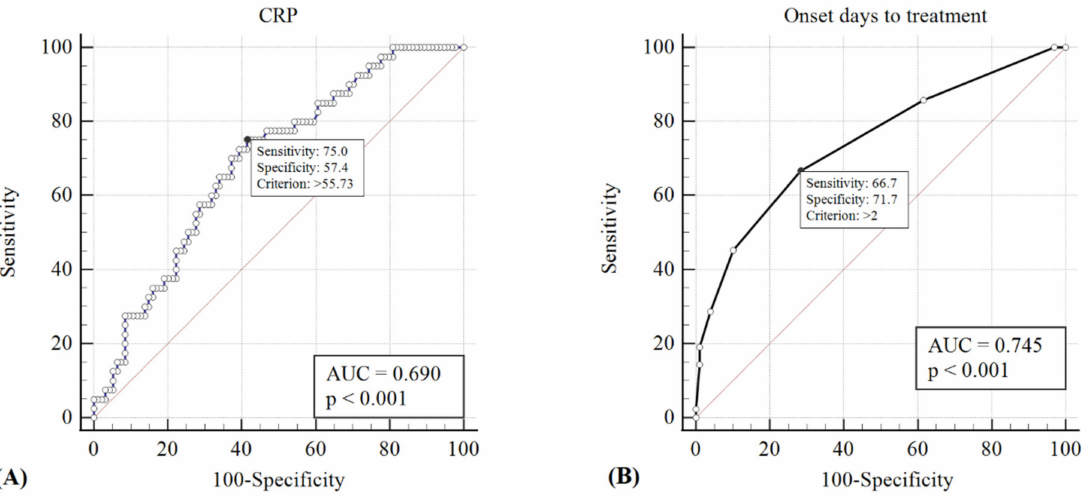
Figure 2. The cut-off points of CRP value >55.73 mg/L ( A ) and initiation of intravenous antibiotics >2 days from onset of periorbital swelling ( B ) showed the best predictive power for the necessity of surgical drainage (sensitivity = 0.75 and 0.67, specificity = 0.57 and 0.72, respectively); the respective AUCs were 0.69 and 0.75 ( p <